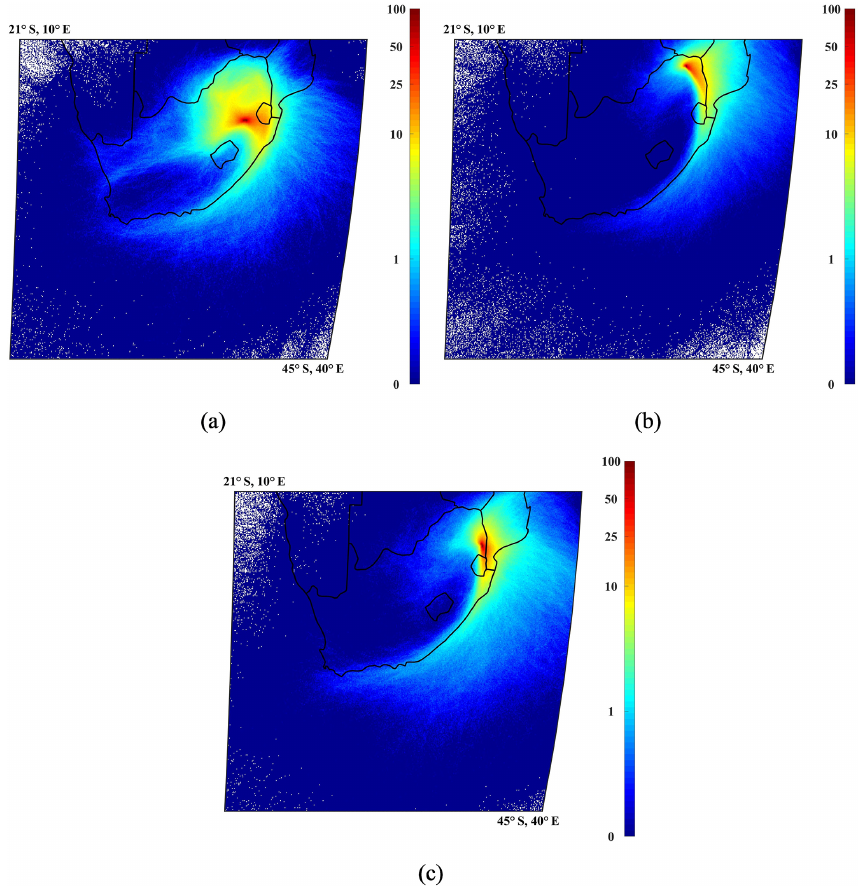
Figure 2. Overlaid hourly arriving 96h back trajectories for air masses arriving at (a) AF from 1997 to 2015, (b) LT from 1995 to 2015 and (c) SK from 2000 to